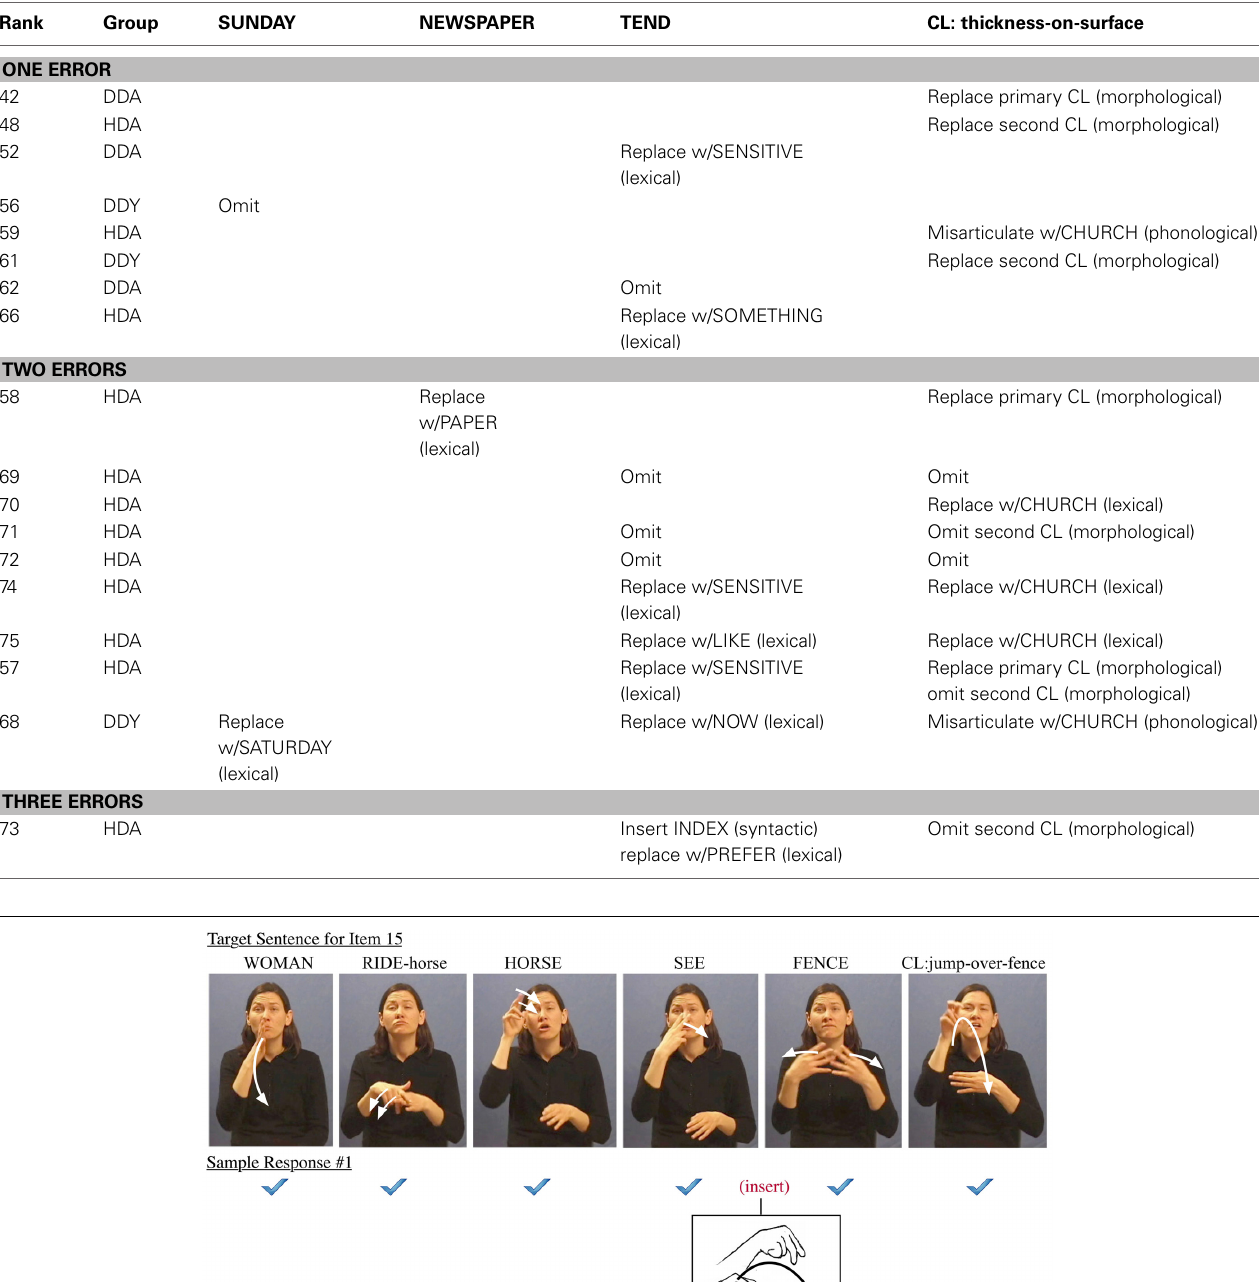
Table 5 | Frequency and type of error made for sentence item 7.